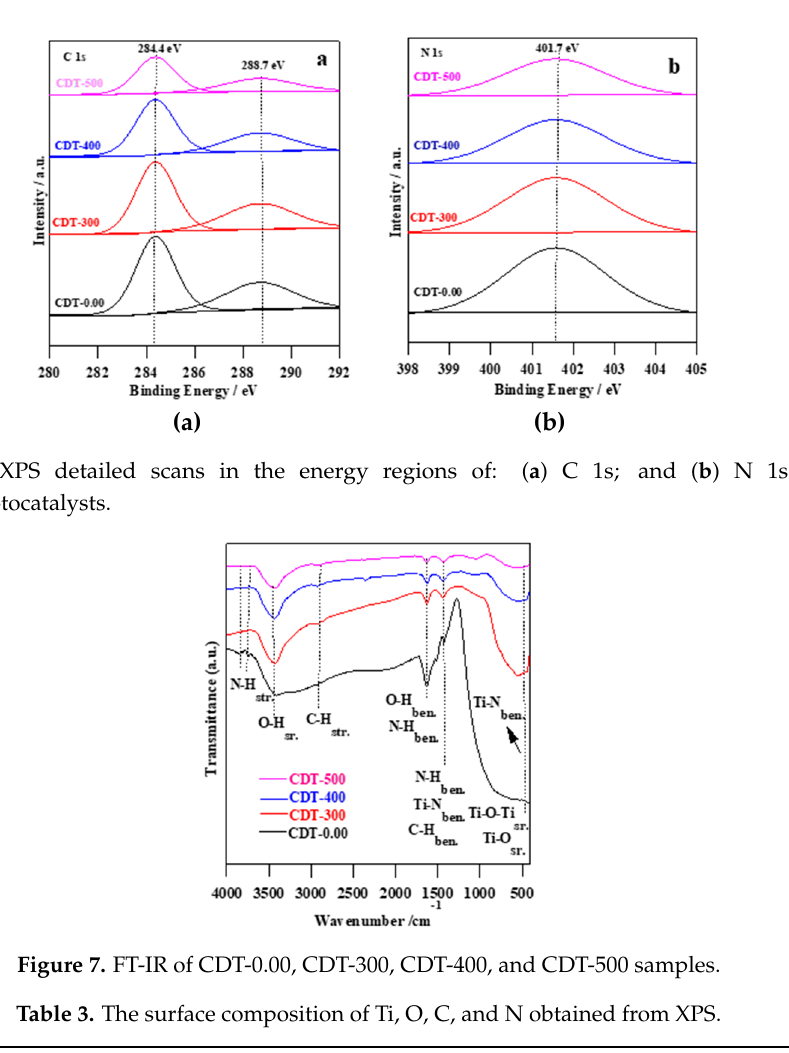
Figure 5. XPS detailed scans in the energy regions of: ( a ) Ti 2p; and ( b ) O 1s of all samples.